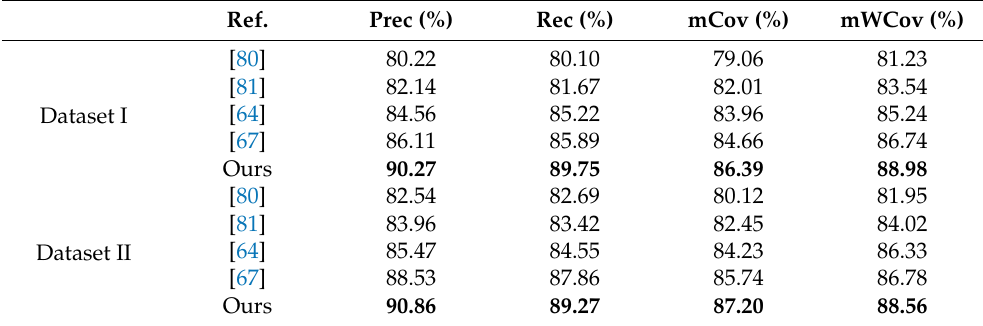
Table 2. Instance-level tree segmentation quantitative evaluation on Dataset I and Dataset II. Best results in bold.